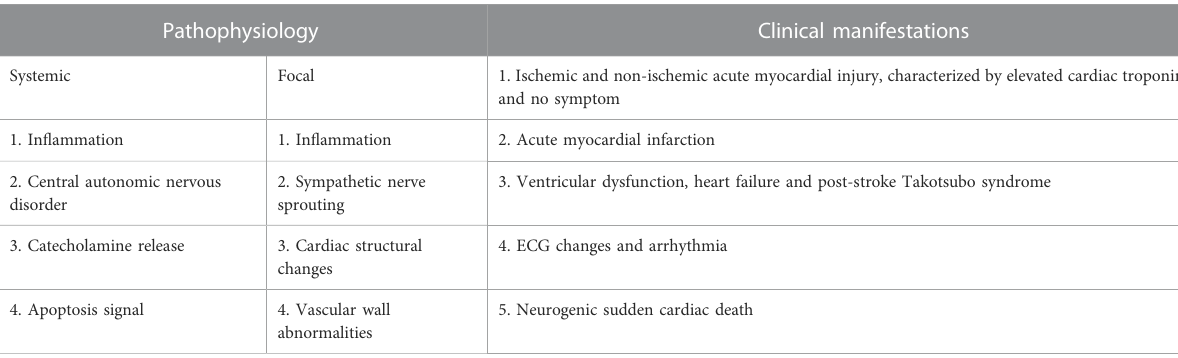
TABLE 1 Clinical and pathological manifestations of Stroke-heart